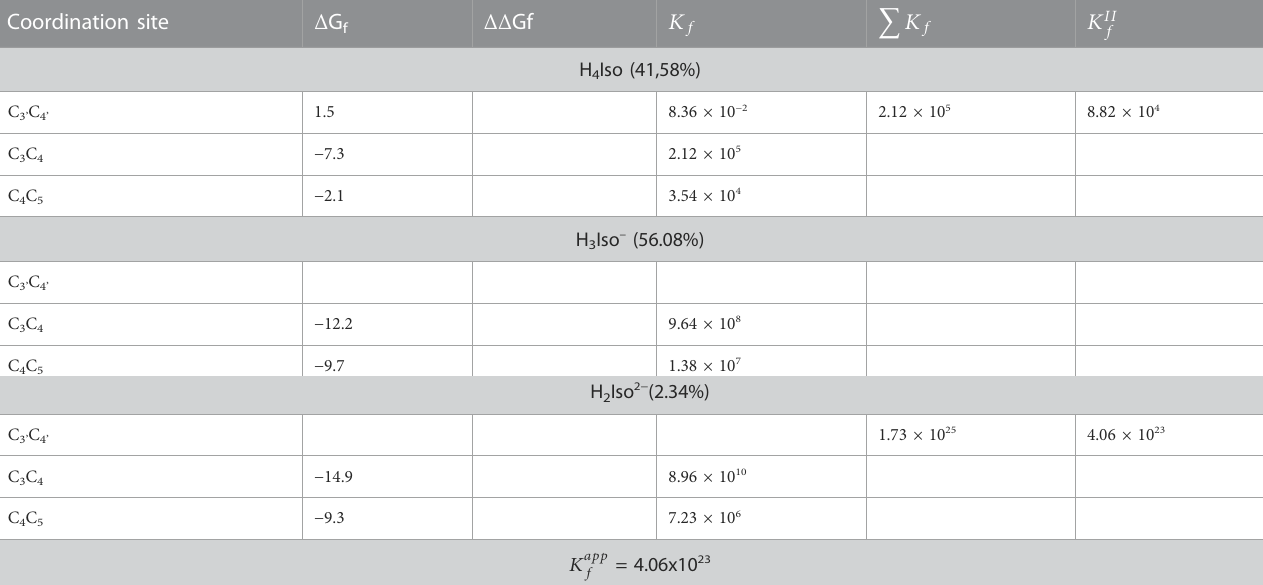
TABLE 6 The Gibbs formation energies ( Δ G f ), their differences ( ΔΔ G f ), both in kcal/mol, and kinetic constants ( K f , (cid:4) K f , K II f and K app i in M − 1 s − 1 ) for the different coordination sites of isorhamnetin with Cu (II) ion in 1:2 ratio. Coordination